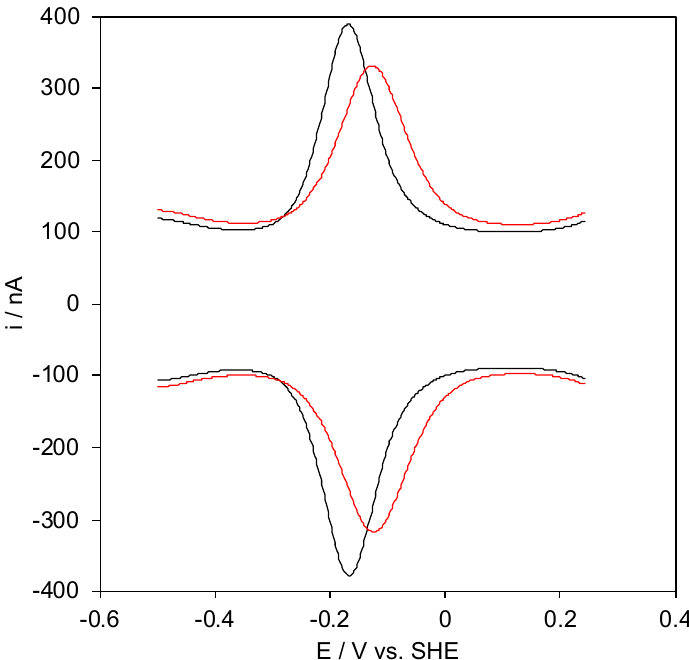
Figure 2. Cathodic and anodic Square Wave Voltammograms of the M80A cytc variant in 0% (black line) and 50% (red line) DMSO. Base electrolyte: 5 mM sodium phosphate buffer pH 7 plus 100 mM sodium perchlorate, T = 293 K.